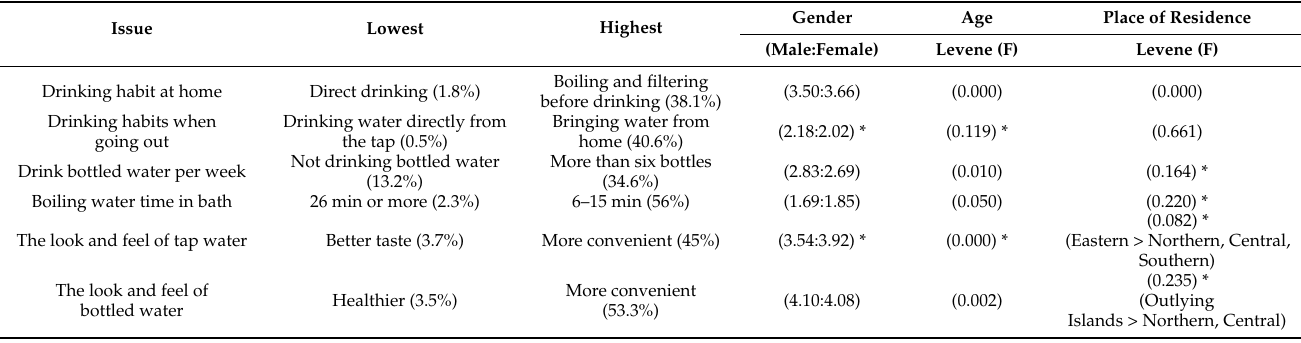
Table 2. Water use awareness analysis of the Taiwanese public.